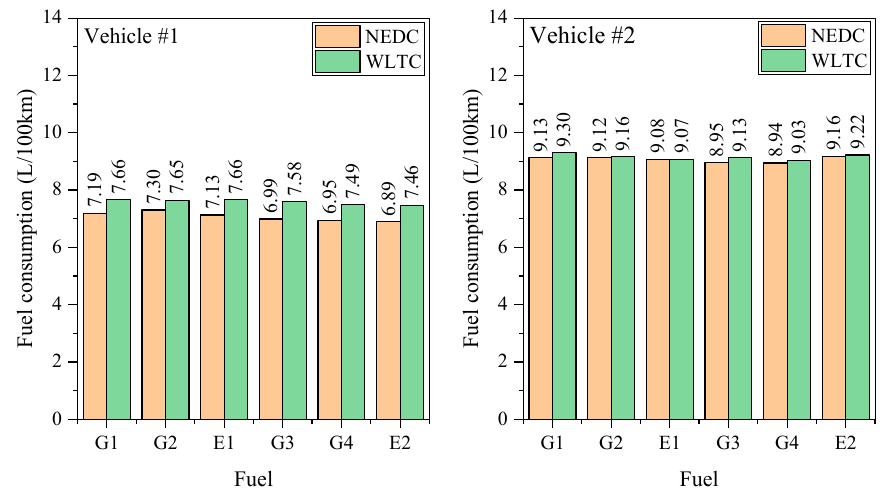
Figure 3. Specific fuel consumption rates for the six